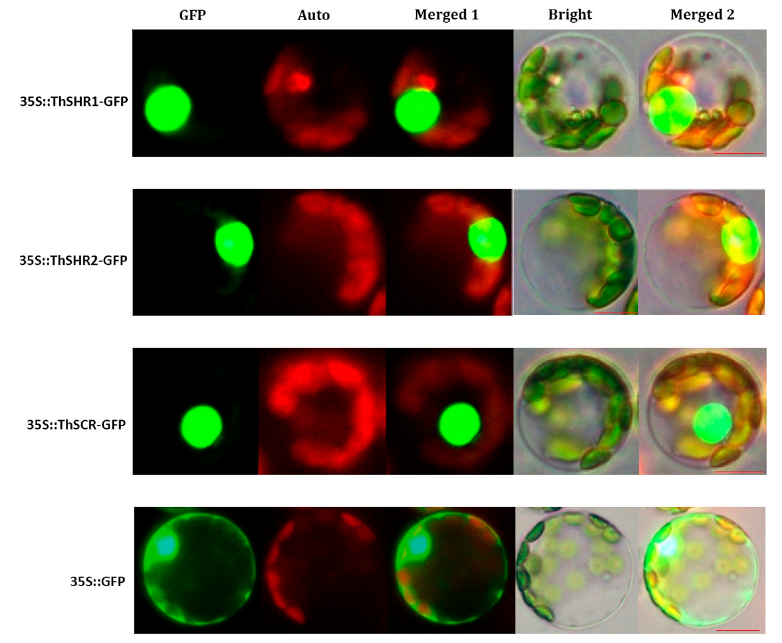
Figure 6. Subcellular localization of ThSHR1, ThSHR2 and ThSCR. Green fluorescent protein (GFP), chlorophyll auto fluorescence (Auto), merged1, bright and merged 2 images are shown. Scale bar: 5 μ m. The 35::GFP fusion was used as the positive protein control, and was detected in the nucleus and cytoplasm of Populus protoplasts.